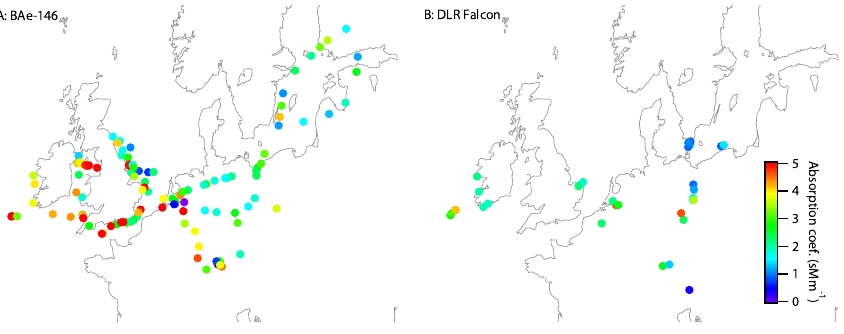
Fig. 7. Maps showing average aerosol light absorption coefficients measured by particle soot absorption photometers on the (a) FAAM and (b) DLR research aircraft. Observations are restricted to periods when the aircraft were below 3km